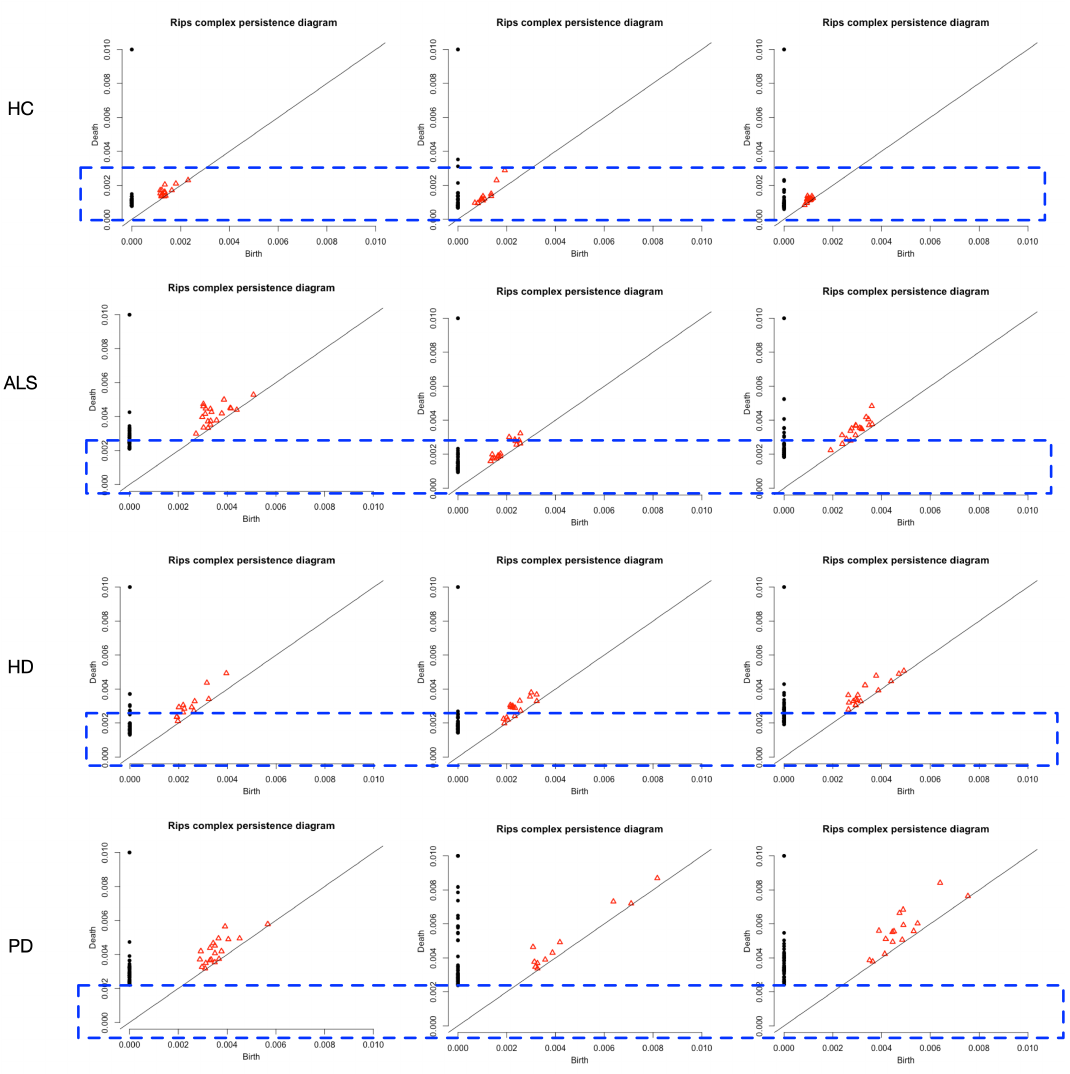
Figure 9. An illustration for the persistence diagrams for each group. First row for HC; second row for ALS; third row for HD; fourth row for PD. Each sub-figure corresponds to the sub-figure in Figure 8. With the blue box-based indicator, we can see that in the HC group, the red triangles are inside of the box, while the others are